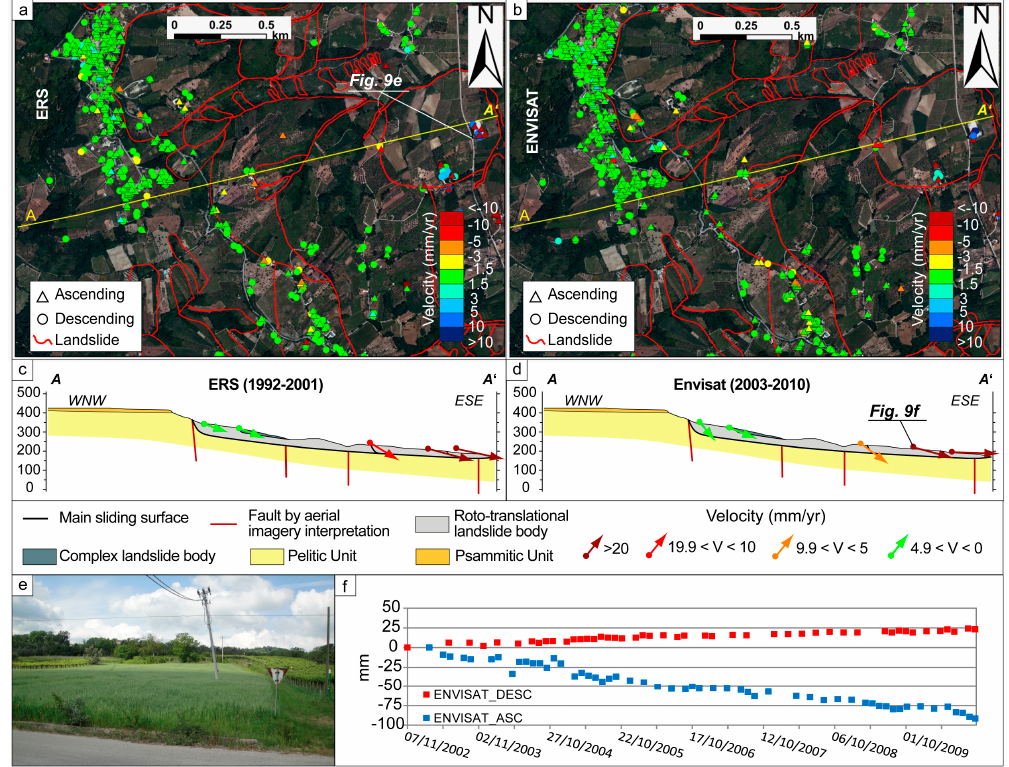
Figure 9. Section of an investigated landslide characterized by strong horizontal component: ( a , b ) Ascending and descending PS results related to ERS and Envisat datasets, respectively. The yellow line A-A’ identifies the landslide section track drawn beside for: ERS ( c ); and Envisat ( d ) datasets. Colored vectors represent displacements along the slope taking into account vertical and horizontal components derived by combining ascending and descending results. ( e ) Pylon affected by instability near the landslide foot. ( f ) Ascending and descending time series of displacement related to PSs used to derive the indicated displacement vector for the Envisat period.